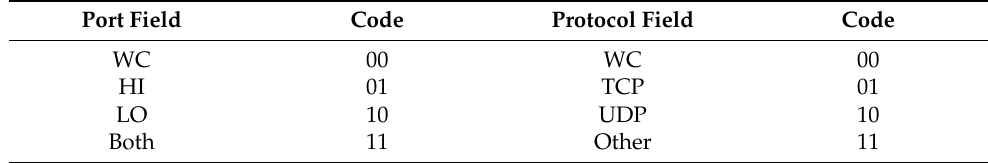
Table 9. Code of the combined comparison results.